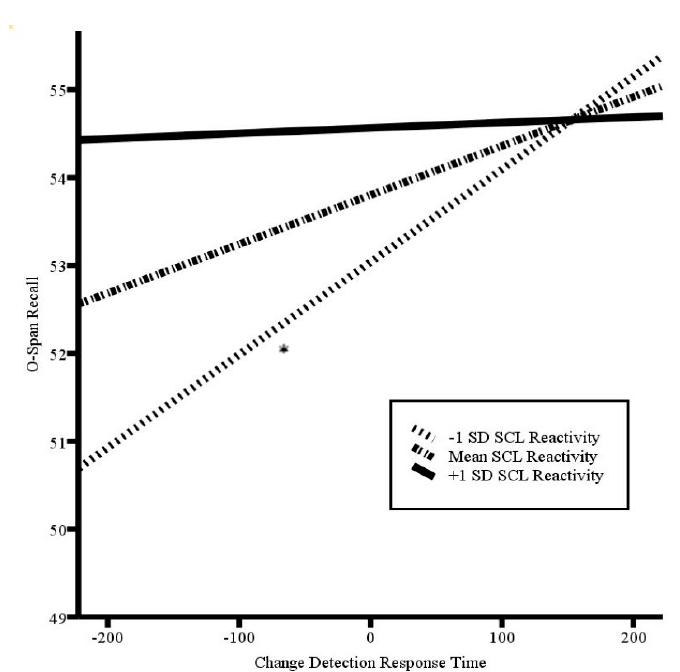
Figure 2. Plot of simple slopes of the centered change detection response time by skin conductance level (SCL) reactivity in predicting O-Span recall, controlling for trait anxiety level; * p < 0.05. Higher scores on the O-Span recall represent greater attentional control. Higher scores in change detection response time indicate slower response time relative to the average detection speed (zero) and, therefore, less vigilance.